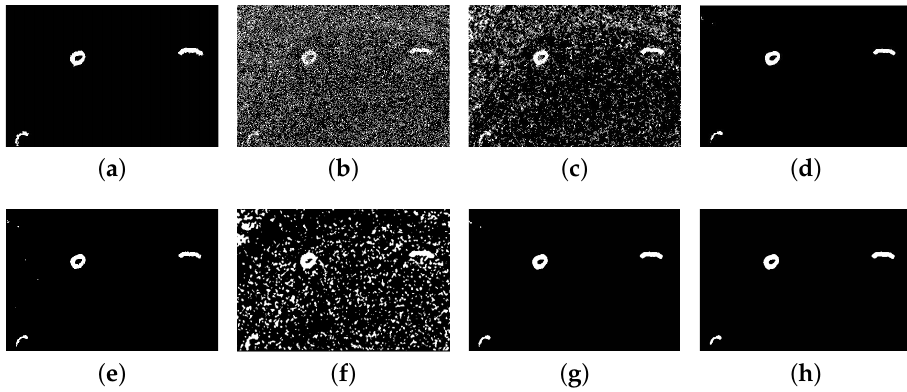
Figure 18. Change detection results on Area b of the coastline data set: ( a ) Reference. ( b ) FCM. ( c ) NLMFCM. ( d ) DBN. (B) SCCN. ( f ) Wavelet fusion. ( g ) gcForest. ( h ) The proposed